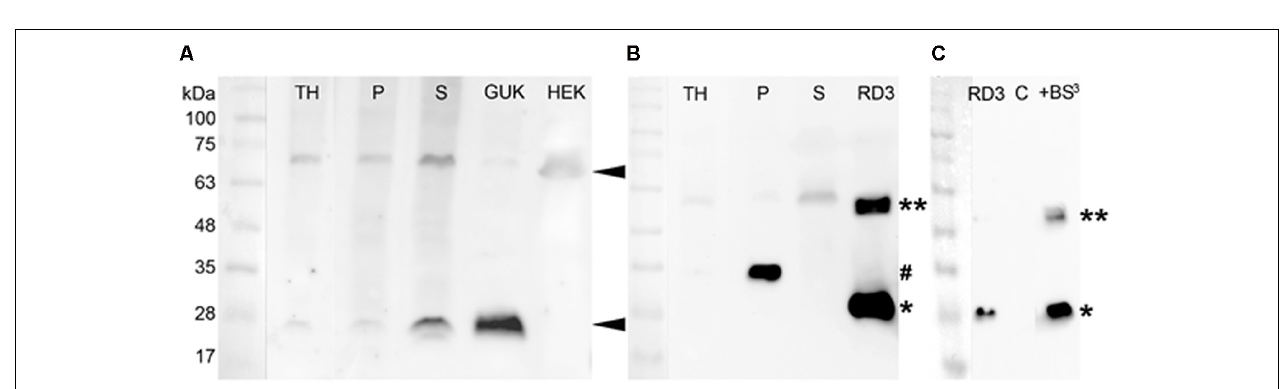
FIGURE 3 | Analysis of GUK and RD3 expression in mouse retina tissue. Reverse transcription of RD3 and GUK analyzed by agarose gel electrophoresis. RNA was extracted from three mouse retina samples (1–3) followed by reverse transcription into cDNA. PCR products obtained with GUK and RD3 specific primers are shown. Exact lengths of transcripts are: GUK isoform 1, 600 bp; GUK isoform 2, 621 bp; RD3, 585 bp. RNA quality check was done with intron-spanning actin primers, indicating no contamination of the samples with genomic DNA, and PCR products were sequenced for correctness.